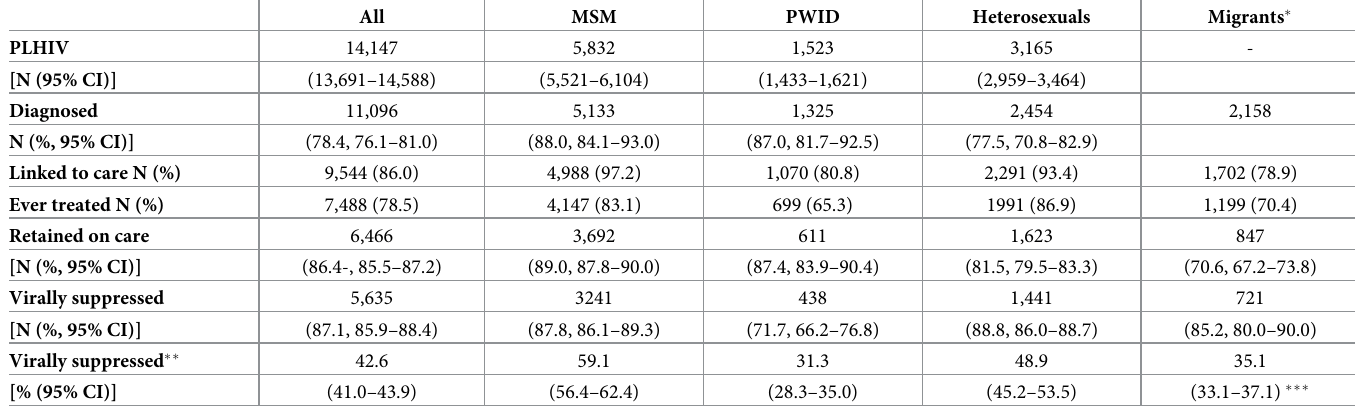
Table 1. The six-point Cascade of care for all HIV-infected individuals, for the subgroups of MSM, PWID, heterosexual men and women † , and for people originat- ing from a country other than Greece. Individuals in each stage are considered as a subgroup of the previous stage. All MSM PWID